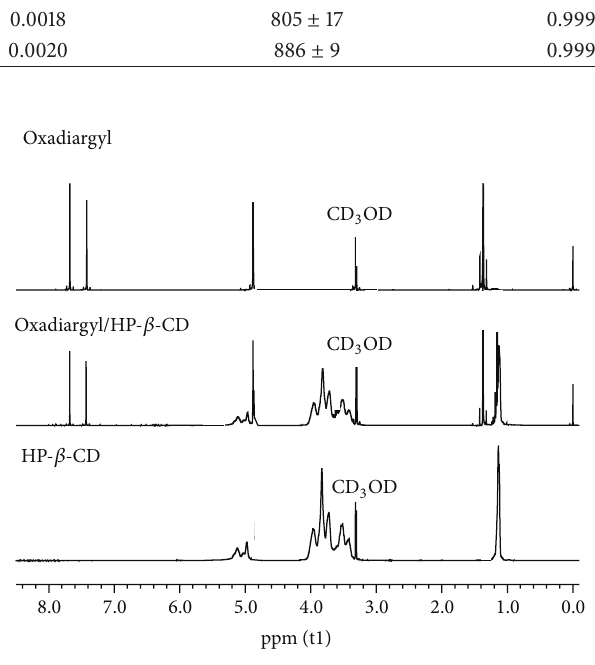
1 H NMR spectra of OXA, HP- 𝛽 -CD, and OXA/HP- 𝛽 -CD inclusion